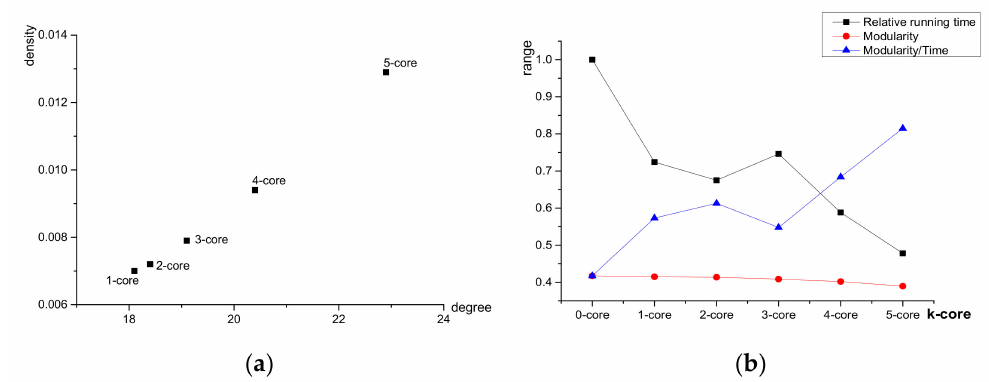
Figure 5. Variations in the network with the K-value. ( a ) Degree and density. ( b ) Modularity and relative running time.